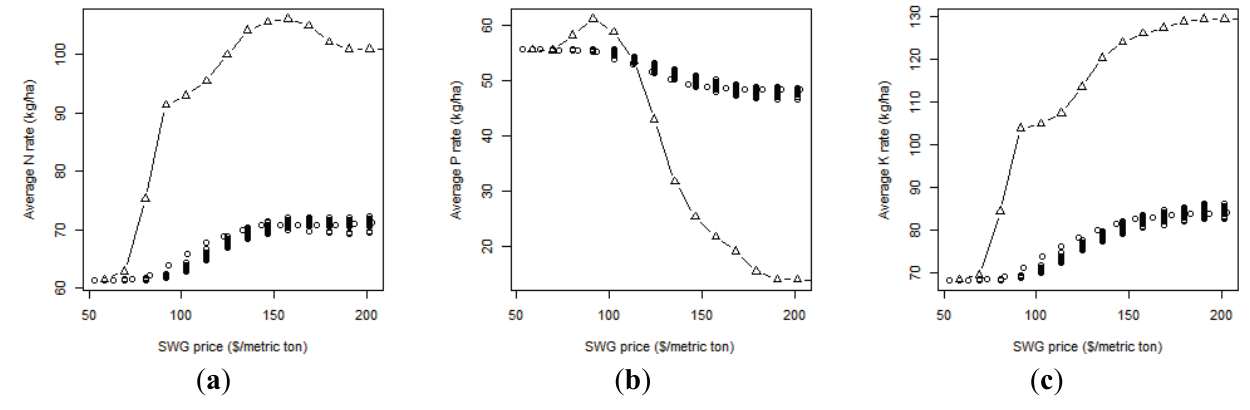
Figure 6. Watershed-averaged fertilizer rates (( a ) N; ( b ) P; and ( c ) K) from 36 simulations (36 SWG price levels and fixed switchgrass to corn stover price ratio of 1.31) on the basis of with (dots) vs. without (triangles in dashed line) land use survey information